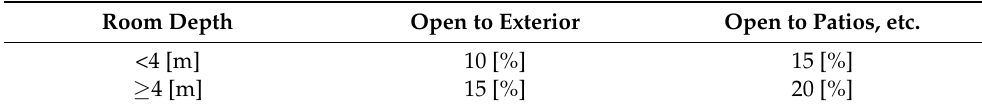
Table 3. Minimum opening area for natural lighting in relation to the useful area of illuminated space, in